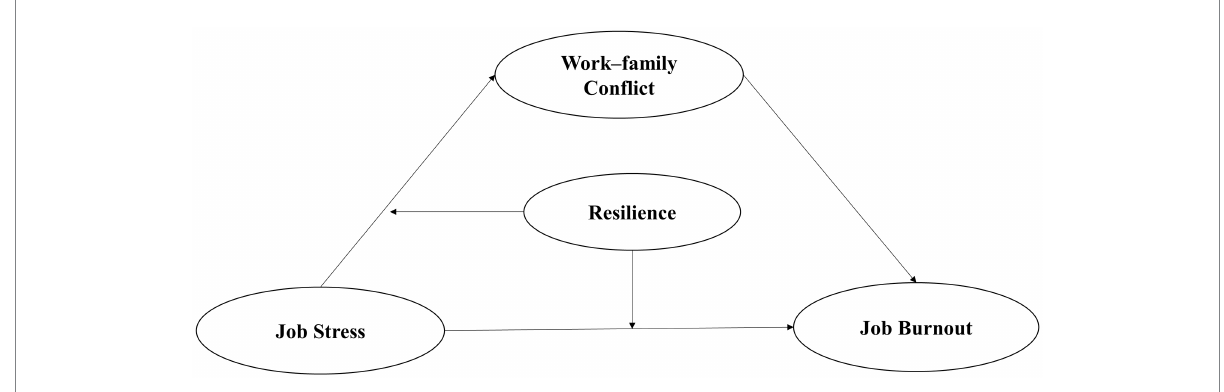
FIGURE 1 The Proposed moderated mediation